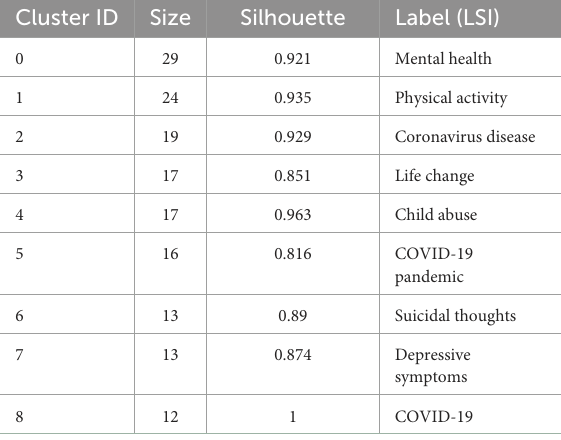
TABLE 6 The largest 9 clusters by